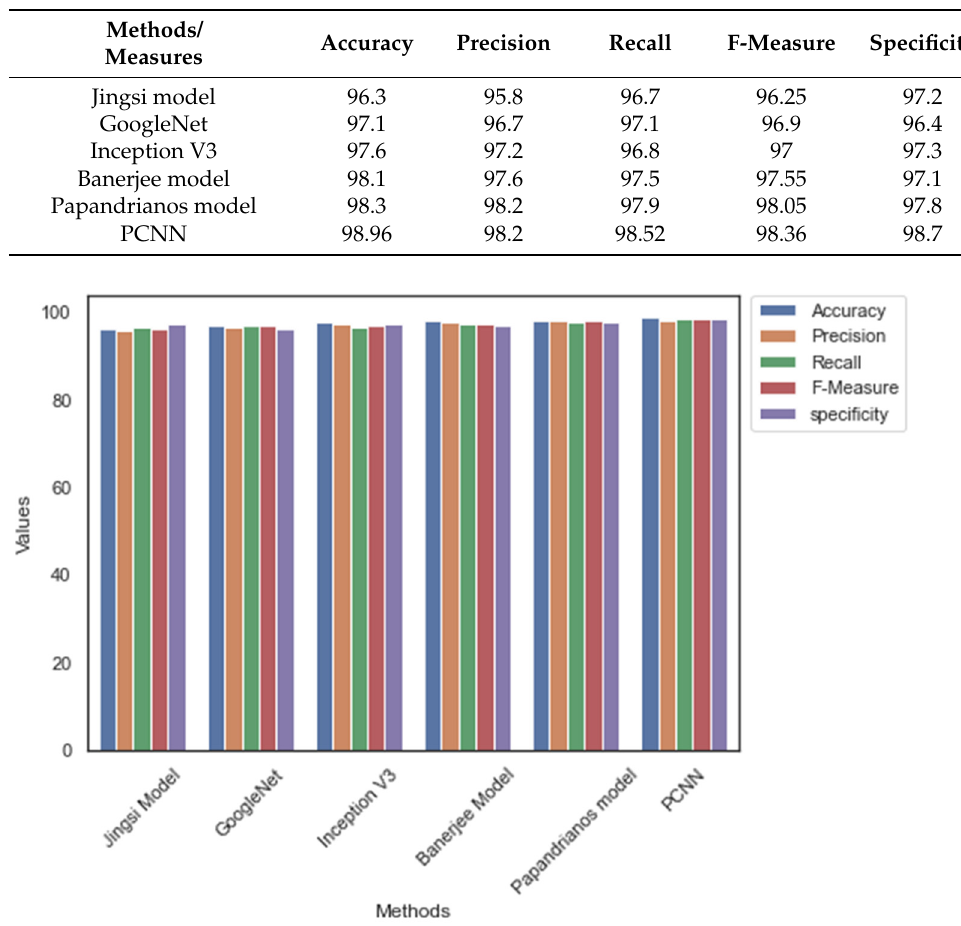
Table 8. Comparative analysis outcome of CNN model for dataset_2.